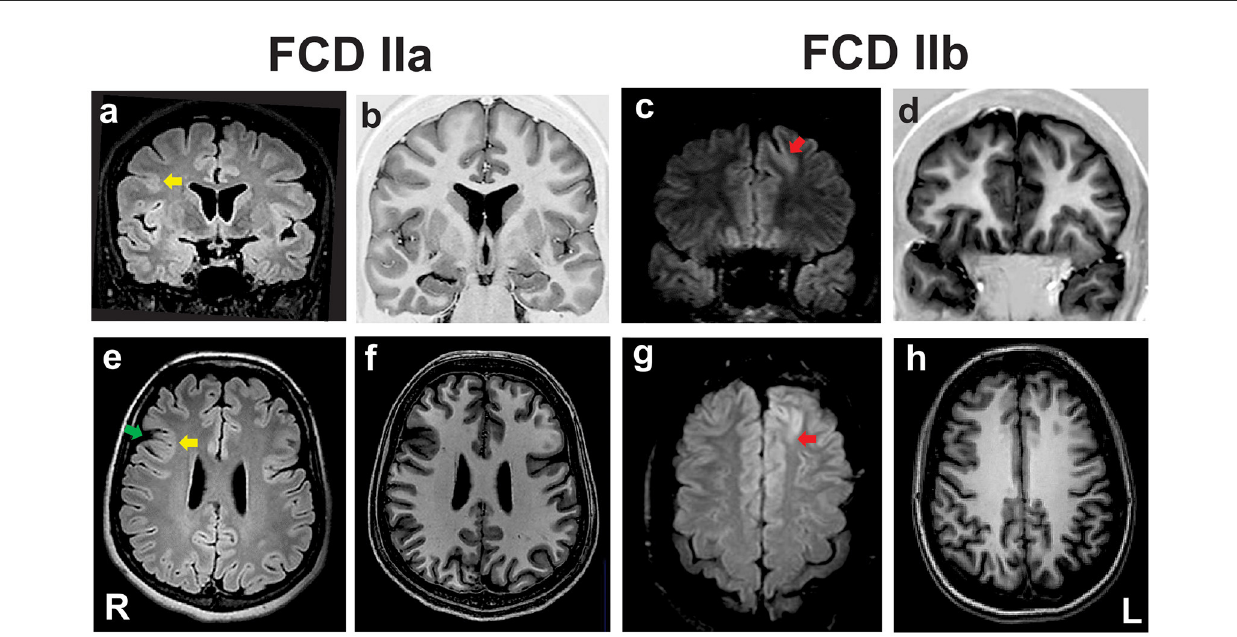
FIGURE1 Preoperative coronal fluid-attenuated inversion recovery [FLAIR; (a, c) ] and T1 inversion recovery (b, d) , and axial FLAIR (e, g) and T1-weighted images (f, h) of two patients with pharmacoresistant frontal lobe epilepsy whose surgical samples showed focal cortical dysplasia (FCD) ILAE type IIa (a, b, e, f) and FCD type IIb (c, d, g, h) . In the patient with FCD IIa there is a discrete hyperintense signal of gray matter in T2/FLAIR [yellow arrows in (a, e) ], mild blurring of the gray-white matter junction in T1 scans, and a cortical dimple indicated by the green arrow in (e) . The patient with FCD type IIb has a deep sulcus with a mildly thickened cortex and hyperintense FLAIR signal in the left frontal lobe [red arrows in (c, g) ]. ILAE, International League Against Epilepsy; L, left side; R, right